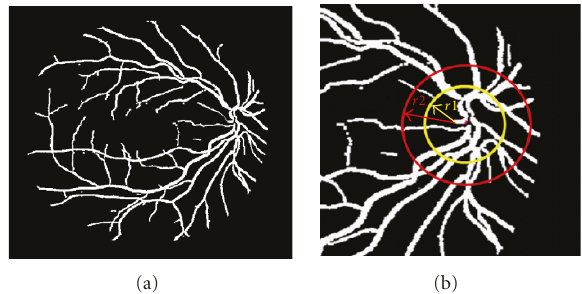
Figure 9: Blood segmentation and masking: (a) vessels pattern, (b) region of interest of vessels images around